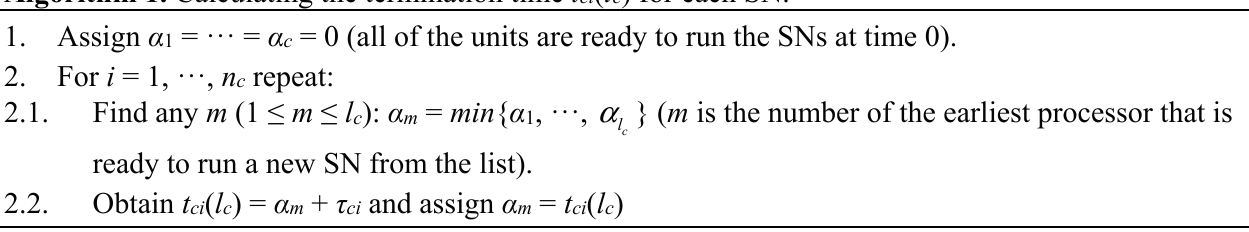
Algorithm 1. Calculating the termination time t ci ( l c ) for each